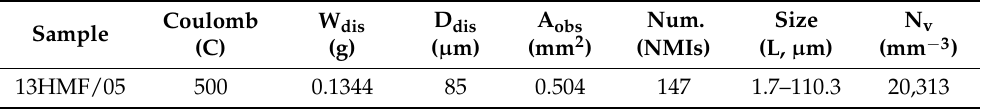
Table 11. Main parameters of EE and SEM observations of elongated sulfides in the steel of 13HMF after heat treatment for 5 min at 900 ◦ C using Method